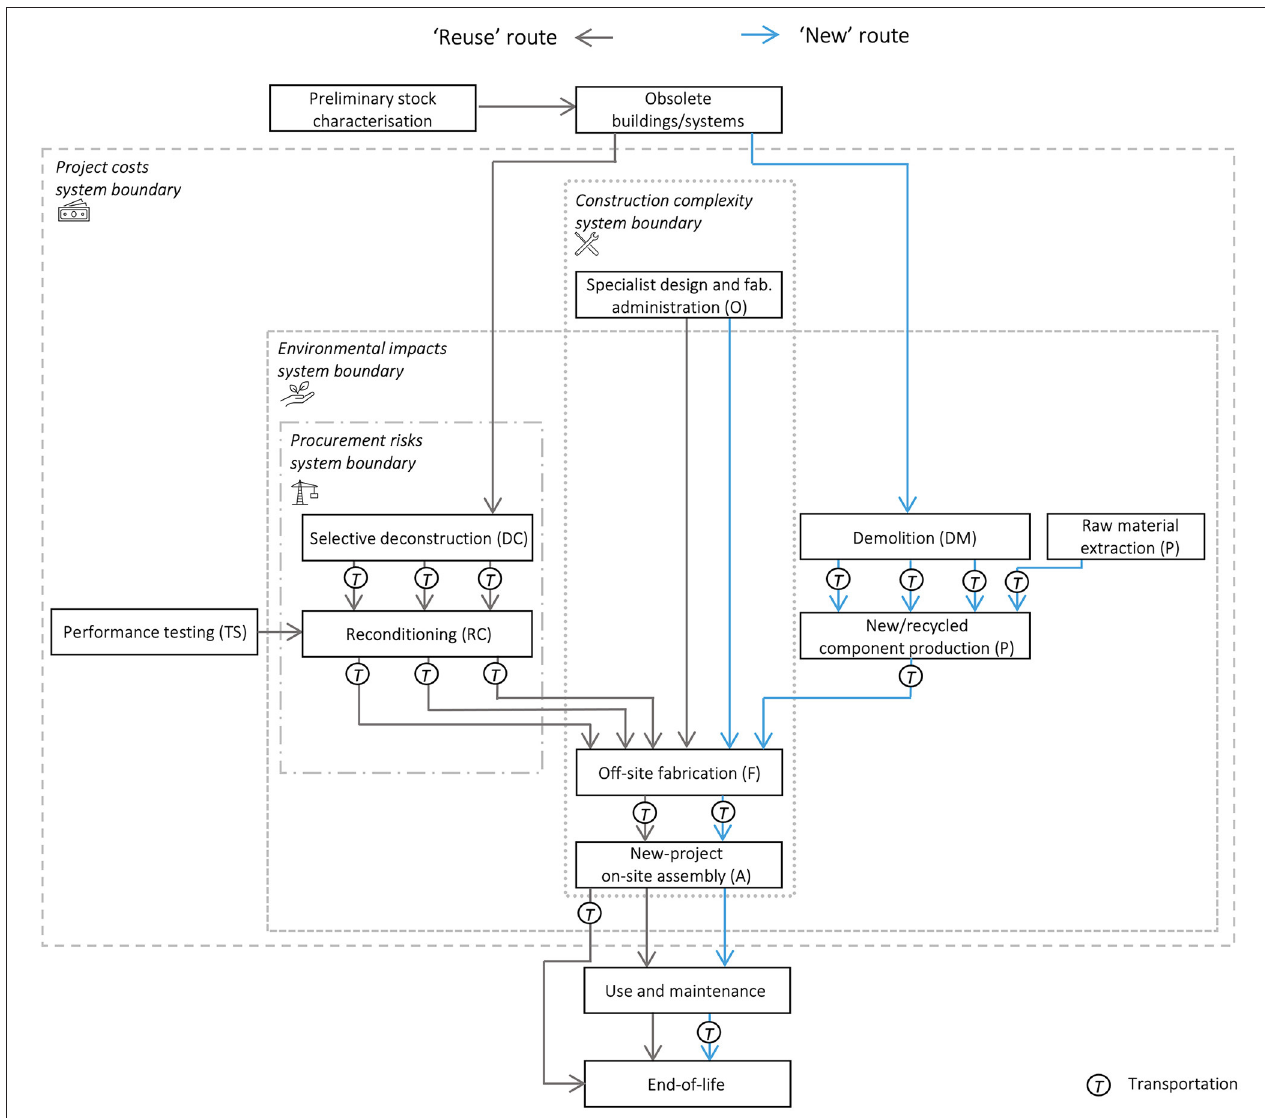
FIGURE 3 | Processes and system boundaries of the four performance